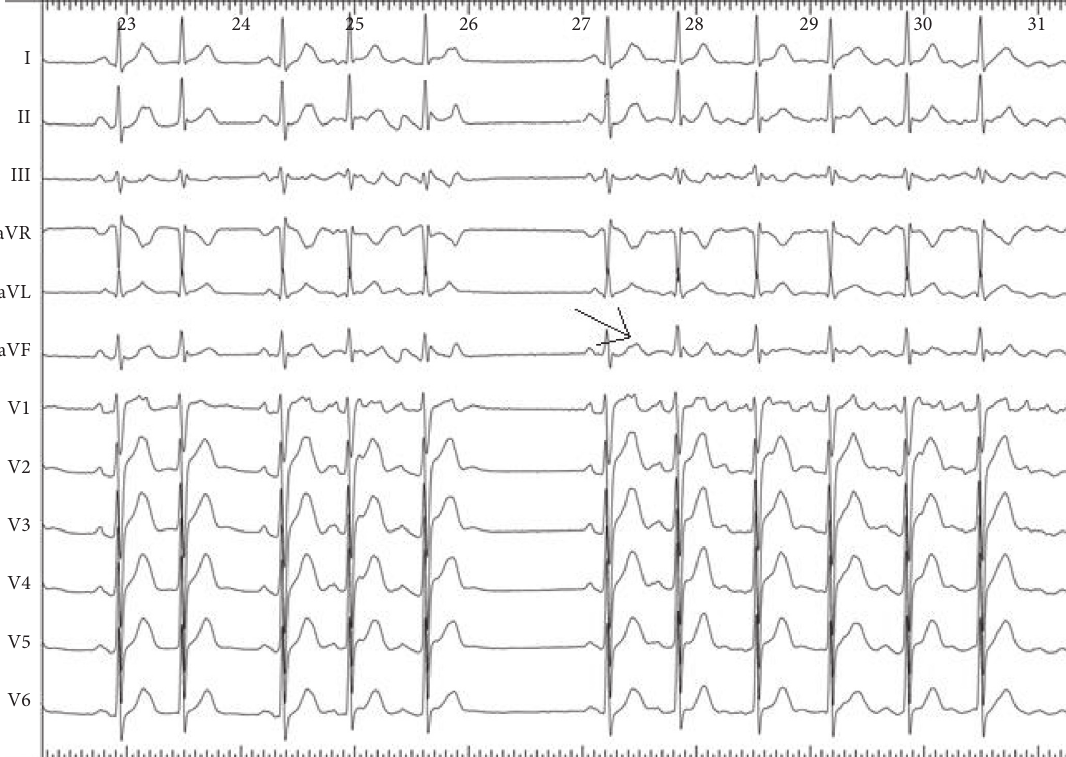
Figure 1: “P on T” phenomena: the trigger of arrhythmia is an extra systolic nonconducted atrial beat with a negative P in D1 and aVL and a positive in D2, D3, and aVF (arrow). This suggests an origin from the left (negative P in D1 and aVL) superior (positive in D2, D3, and aVF) pulmonary vein that was confirmed by the Lasso catheter. The isolation of the left superior pulmonary vein stopped the arrhythmia.